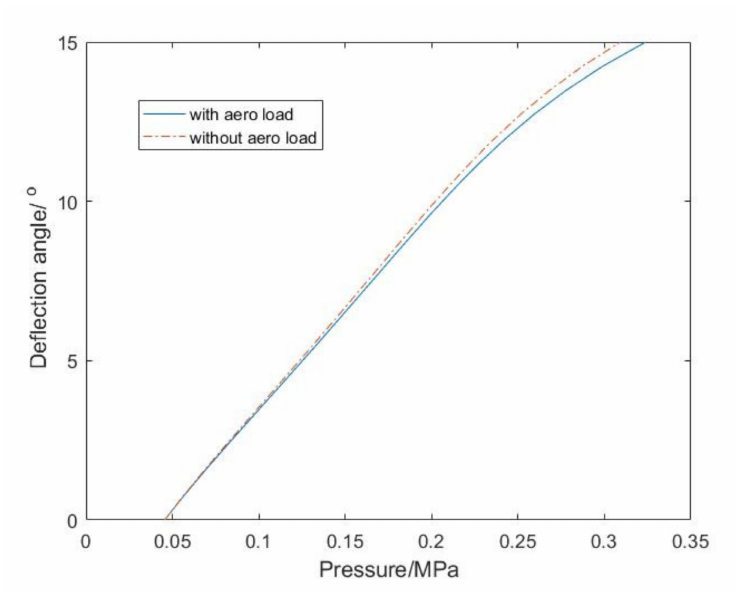
Figure 14. Driving pressure vs. deflection angle under different conditions.